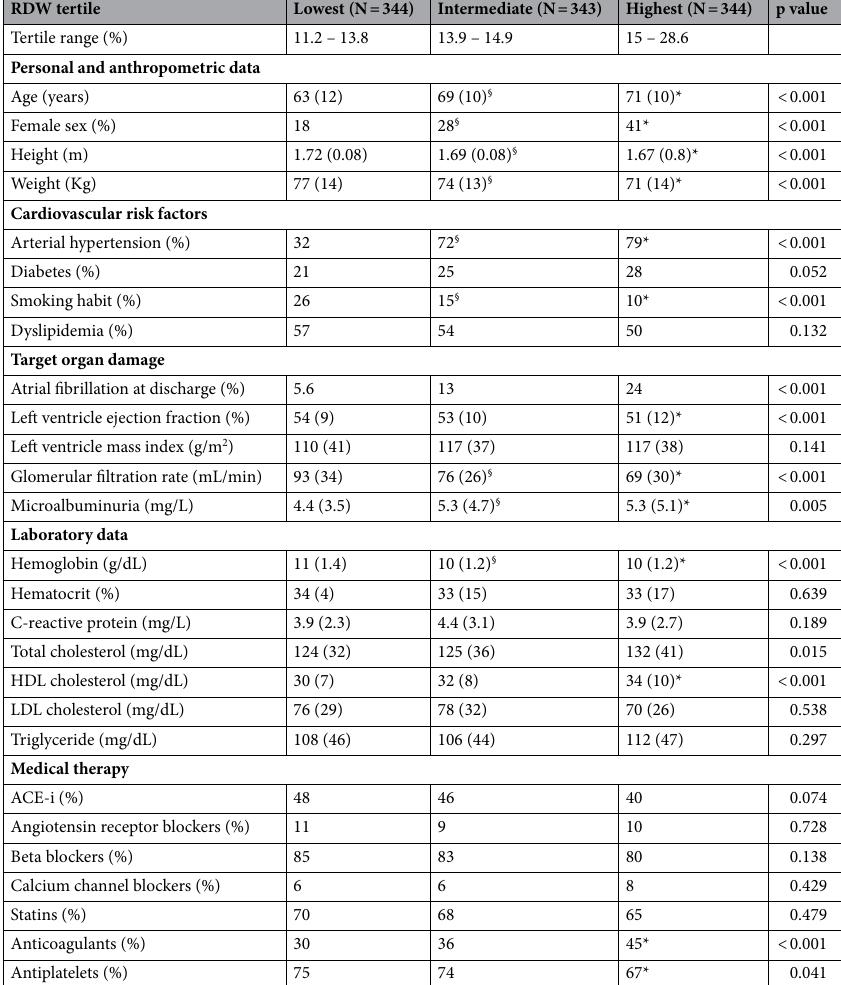
Table 1. Patients’ characteristics by tertile of red blood cell distribution width (RDW). Continuous variables as mean (standard deviation), categorical variables as percentage (%). HDL high-density lipoprotein, LDL low- density lipoprotein, ACE-I angiotensin-converting-enzyme inhibitors; p values after ANOVA for continuous variables, after chi-square test for categorical variables. *Significant differences between the lowest and the highest tertile, § differences between the lowest and the intermediate tertile at p <